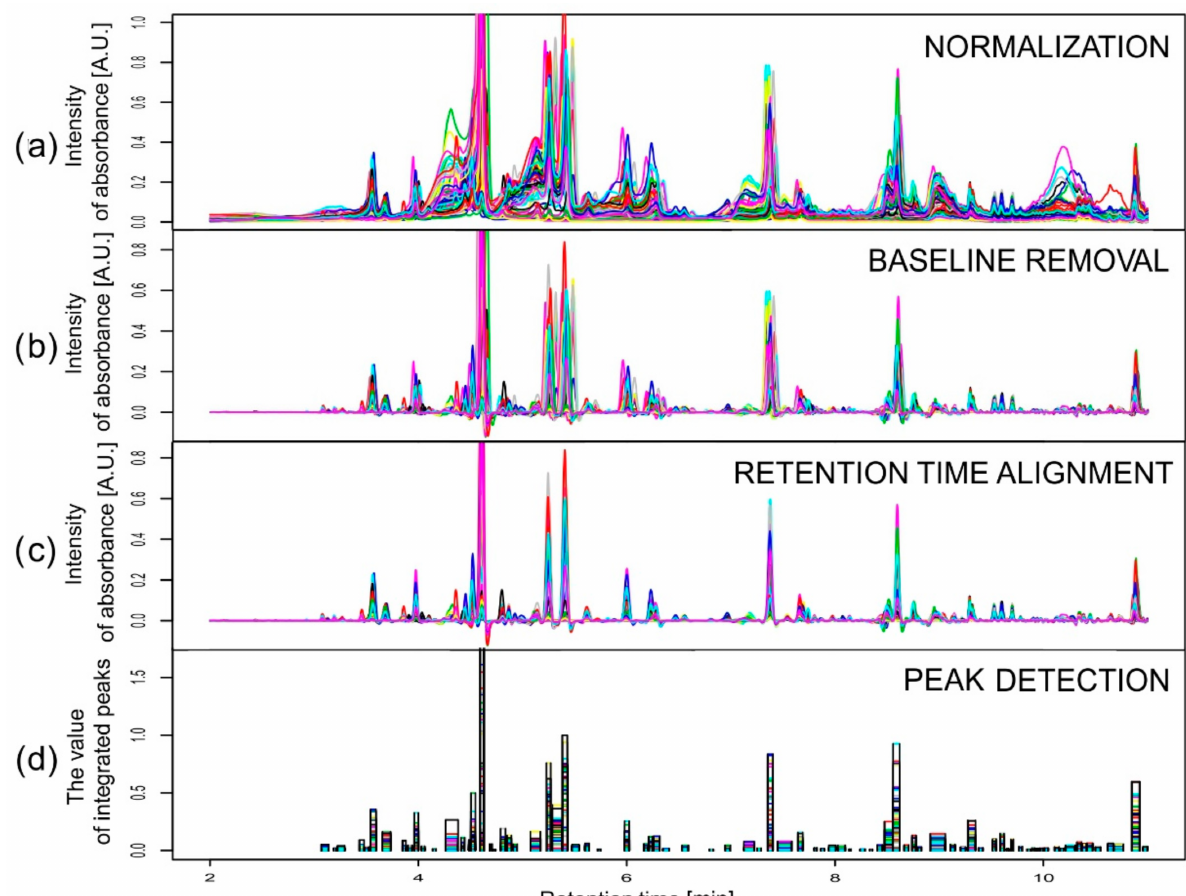
Figure 3. Pre-processing data from chromatograms recorded at 330 nm for Maresi after the following steps: ( a ) normalization by sample mass, ( b ) differentiation, ( c ) correlation optimized warping (COW), and ( d ) peak detection. The last plot shows the width of peaks and their value after integration for individual